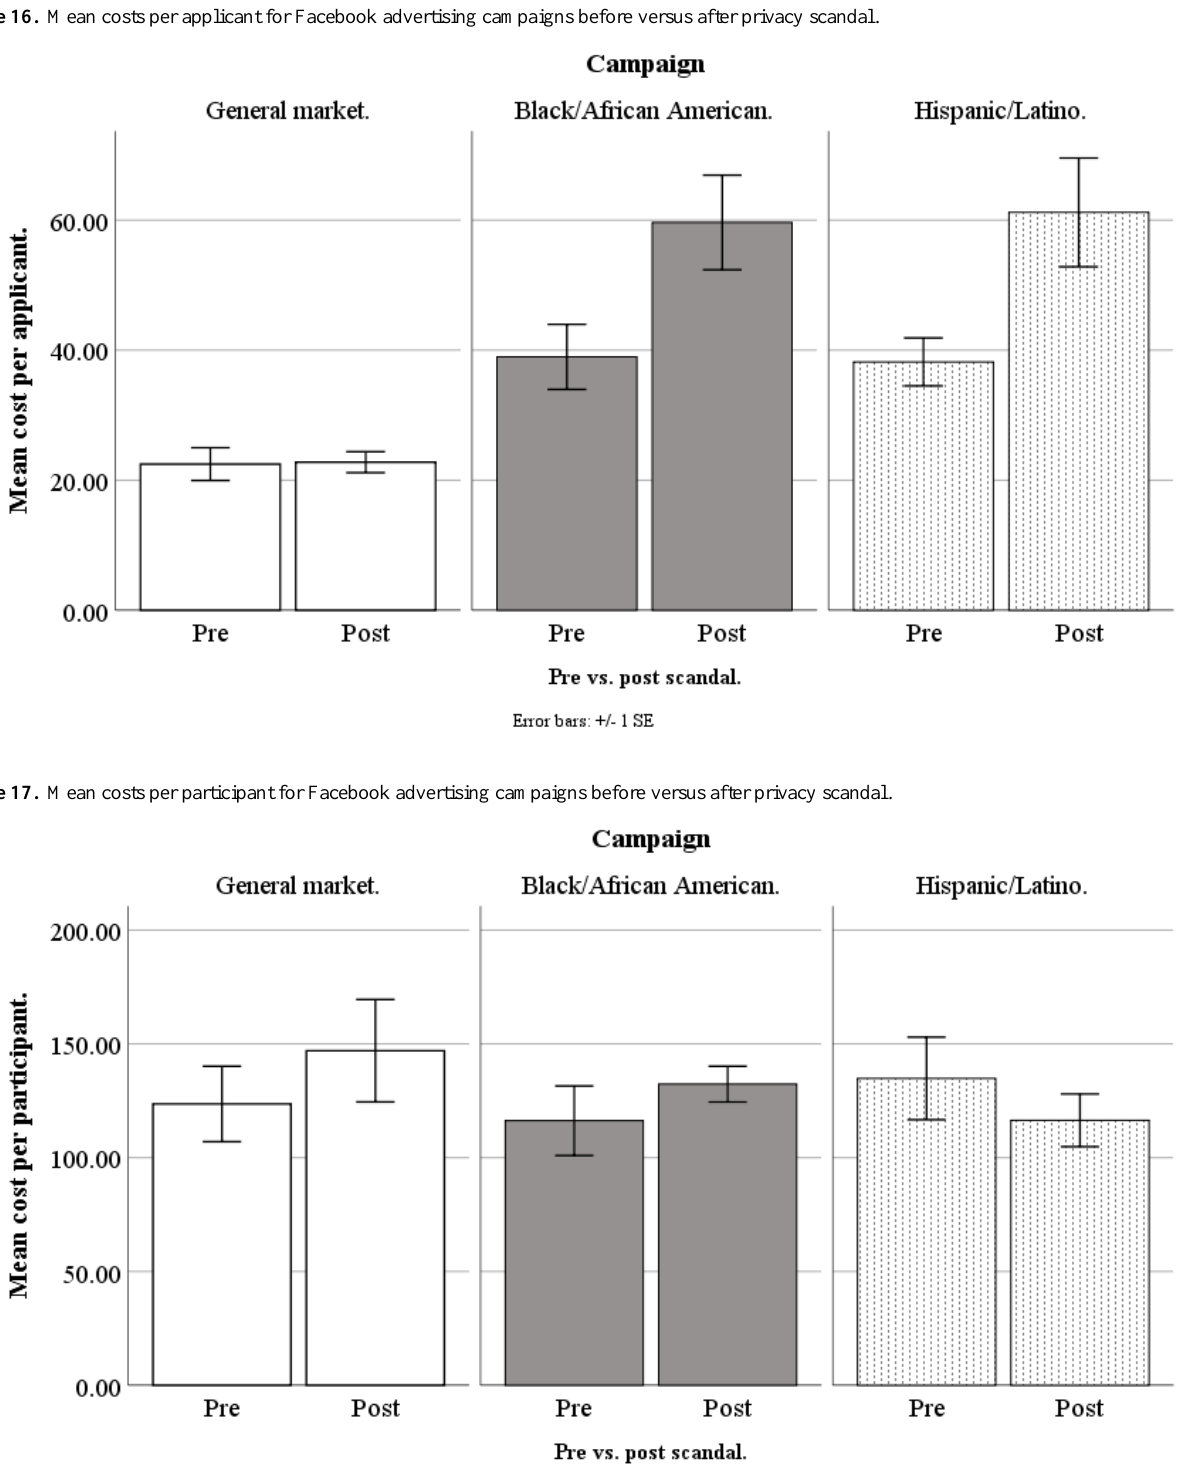
Figure 16. Mean costs per applicant for Facebook advertising campaigns before versus after privacy scandal.